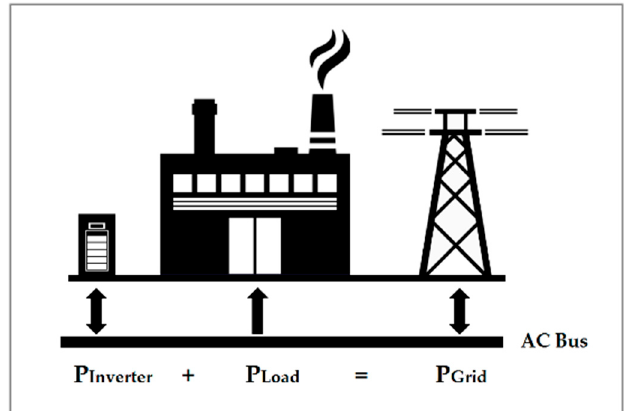
Figure 2. System topology. Table 1. LFP Cell Characteristics, according to [29].